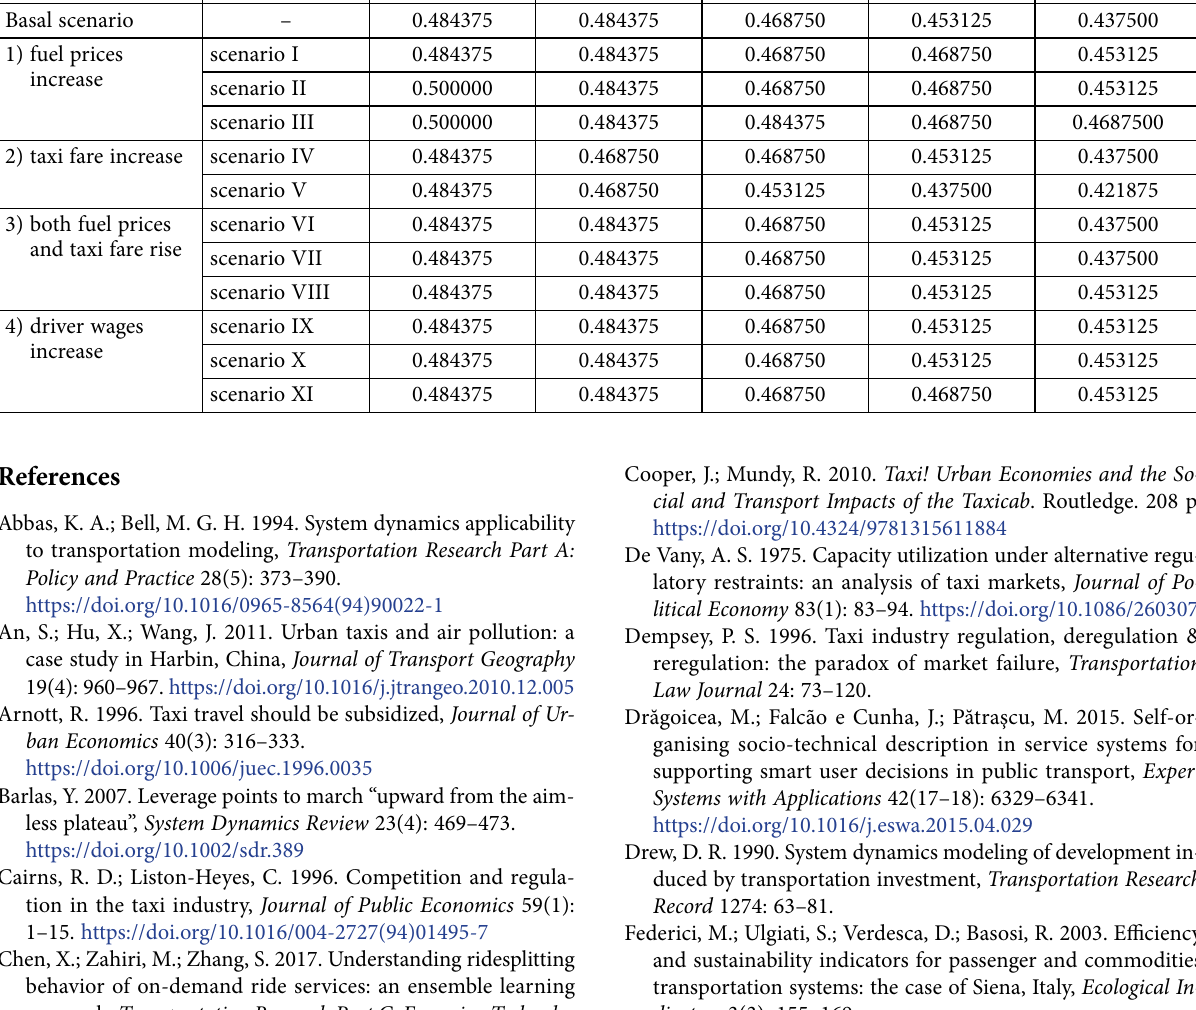
Table A5. The statistics of vacant ratio for taxi operation simulation Scenarios